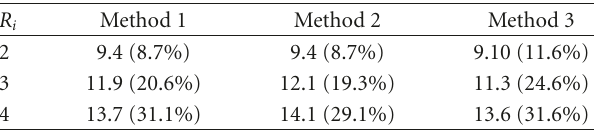
Figure 7: Rate savings achieved by the distributed encoding algorithm (global merging algorithm) versus SNR (dB) with R i = 3 and M = 5 . σ 2 = 0, ... ,0 . 5 2 . Table 1: Total rate, R M in bits (rate savings) achieved by various merging techniques.